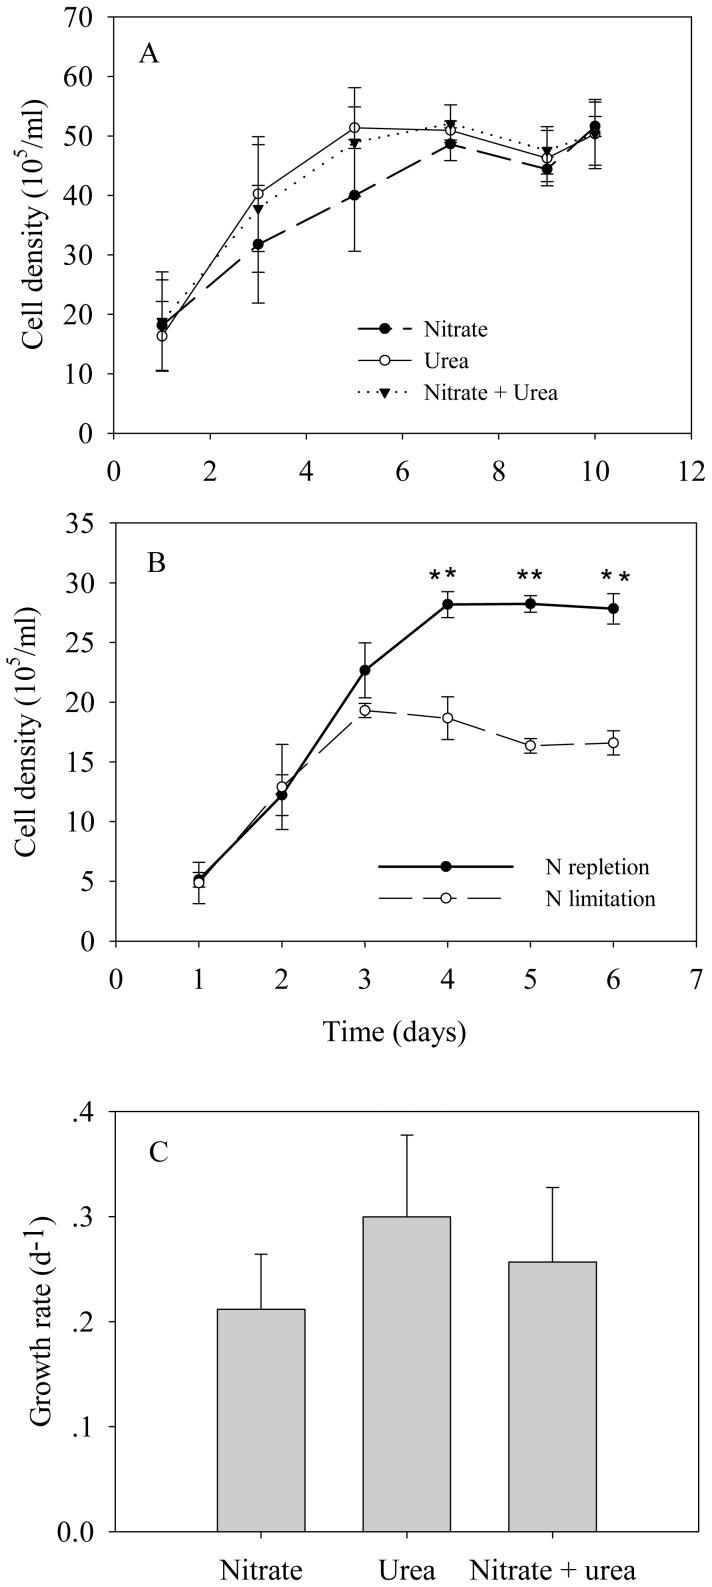
Cell density as a function of culture time.A) Growth of A. anophagefferens grown on urea, nitrate, and a mixture of urea and nitrate. B) Growth of A. anophagefferens under nitrogen-replete and limited conditions. Cell density under nitrogen-limited condition was compared with that under nitrogen-replete condition. Significance values were expressed as follows: * P <0.05, ** P <0.001. C) Growth rates of A. anophagefferens grown on urea, nitrate, and a mixture of urea and nitrate. Error bars represent standard deviation of the mean for the three biological replicates.